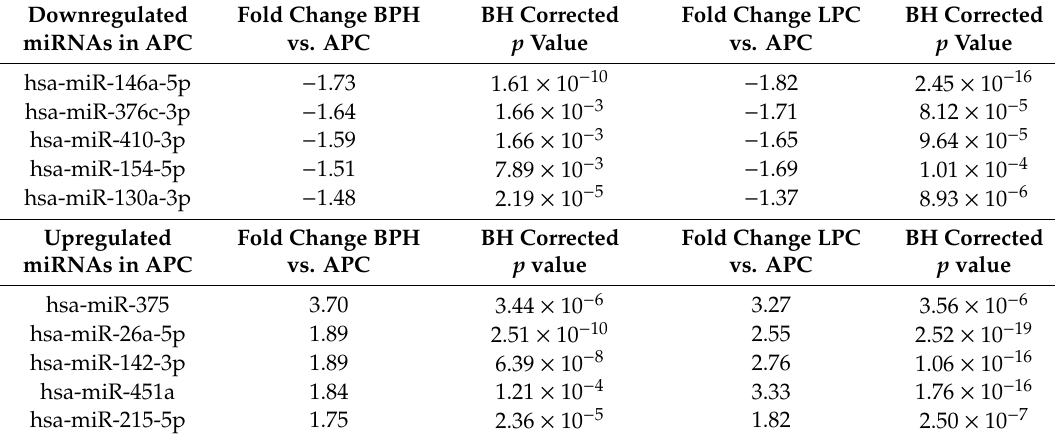
Table 2. Top five miRNAs upregulated and downregulated in APC relative to BPH (left) or LPC (right), ordered by fold change from BPH vs. APC. Benjamin–Hochberg was used to correct p values for multiple